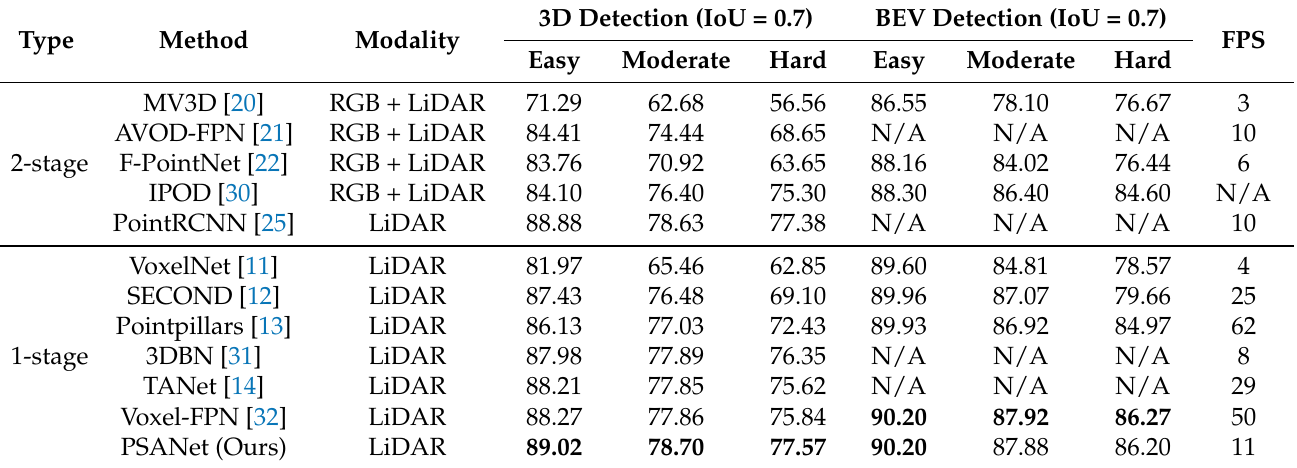
Table 1. 3D detection and bird’s eye view detection performance: Average precision (AP) (%) of the car on the KITTI validation